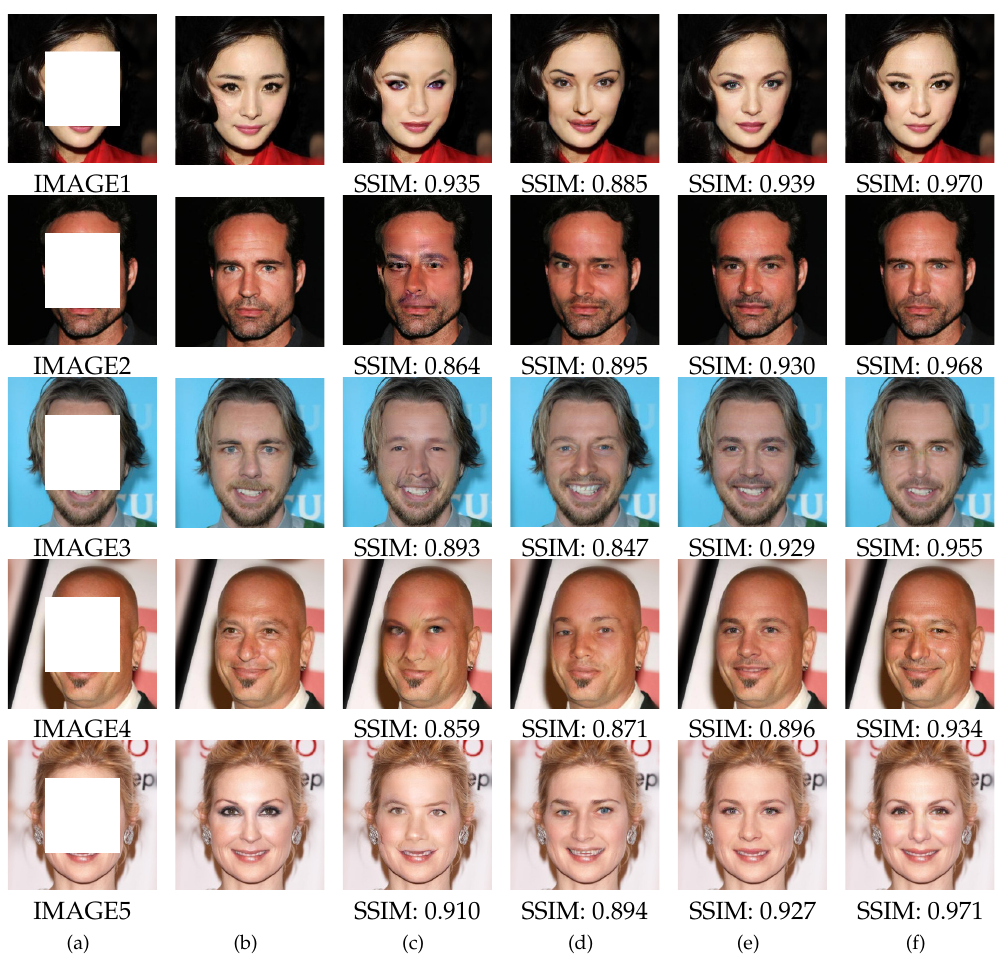
Figure 8. The qualitative evaluation on CelebA-HQ datasets: ( a ) masked input; ( b ) ground-truth; ( c ) results of CA; ( d ) results of PIC; ( e ) results of LaFIn; ( f ) results of RG-DP-FICN.